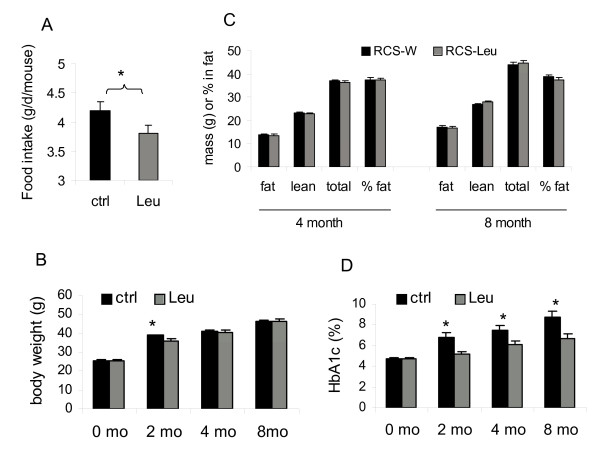
Leucine supplementation improves glycemic control independent of energy balance in NONcNZO10/LtJ (RCS10) mice. A: The average daily food intake measured during the first two months of leucine-treatment. B-D: Body weight (B), body composition (C), and HbA1c levels (D) in the control and leucine-treated RCS10 mice before (0 mo) and after 2, 4, and 8 months of leucine-treatment. * indicates p < 0.05, control vs. leucine-treated, n = 7.